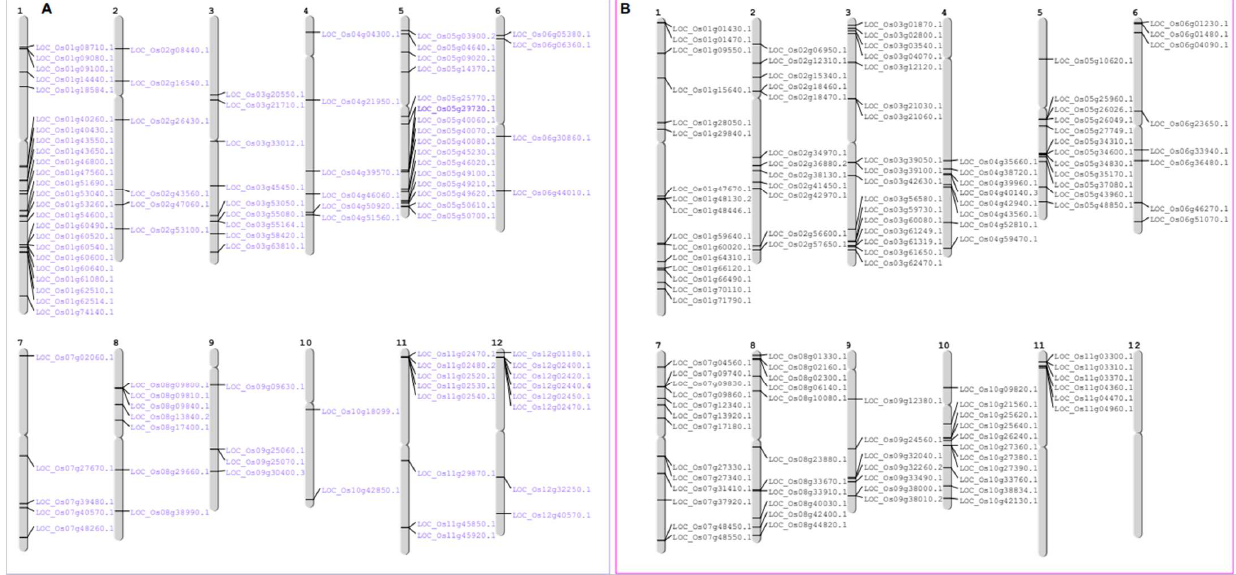
Figure 3. ( A ) Chromosomal localizations of OsWRKY genes on the twelve chromosomes of rice. ( B ) Chromosomal localizations of OsNAC genes on the twelve chromosomes of rice.